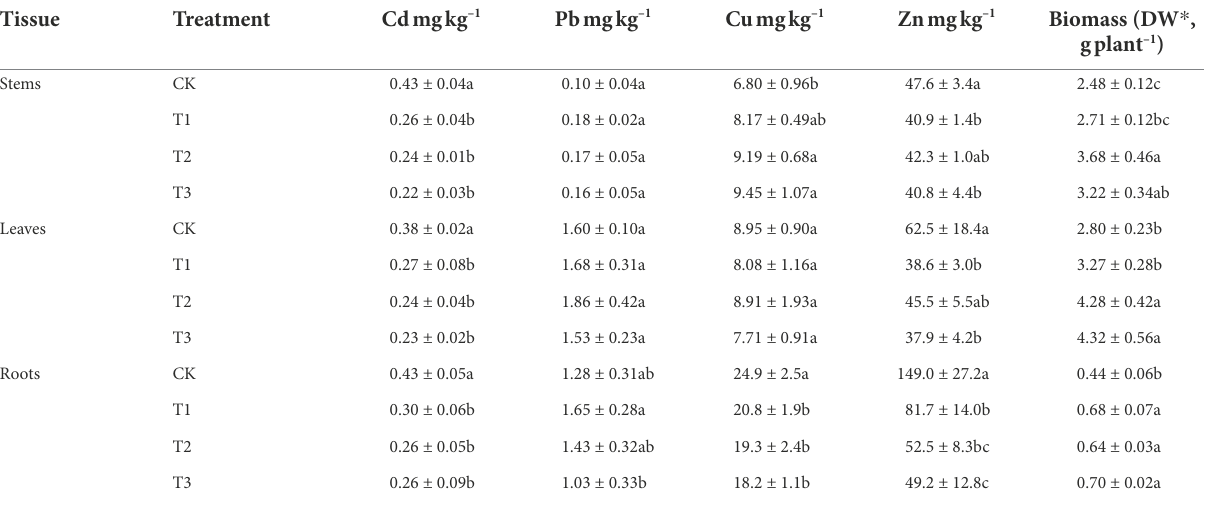
TABLE 3 Effects of compost addition on plant heavy metal concentrations and biomass.